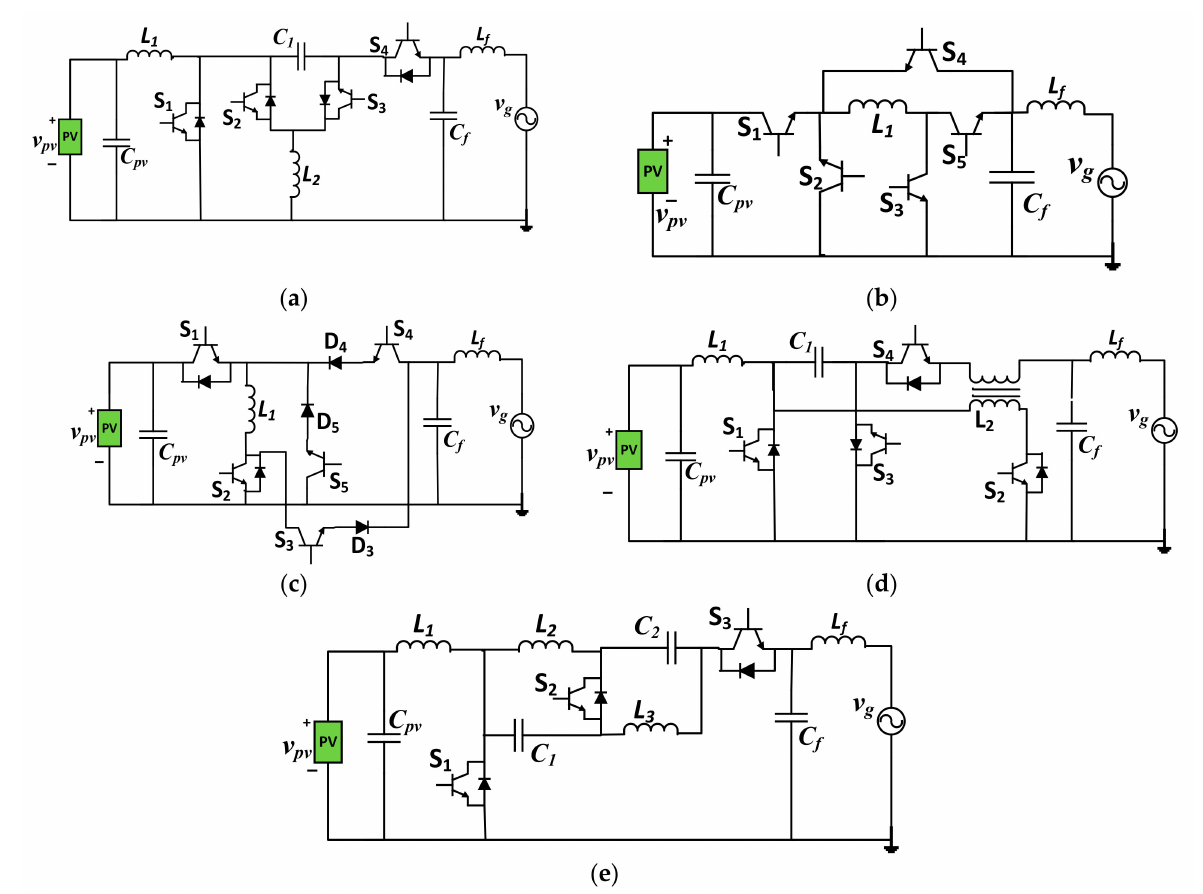
Figure 3. Current-source common-grounded (CSCG) converters. ( a ) Converter presented in the work of [36,37], ( b ) converter presented in the work of [38], ( c ) converter presented in the work of [39], ( d ) converter presented in the work of [40], ( e ) converter presented in the work of